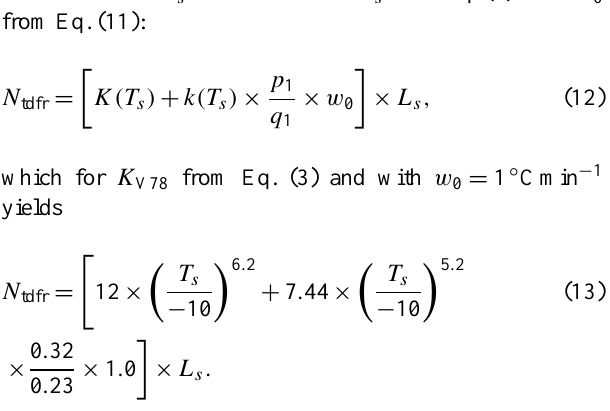
; N s ; and t 90 is the time after arrival at the isothermal N sing